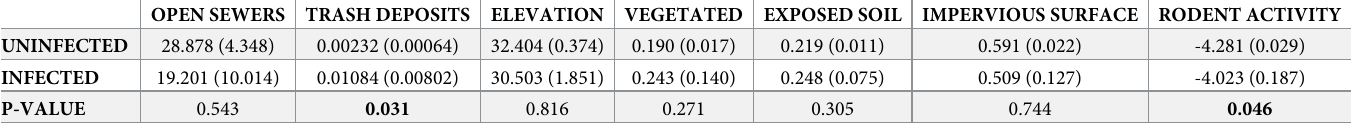
The mean (standard error) exposure to each feature during 24 hours. Exposure values were assigned to a grid of points with 2.5 meter spacing that covered the entire study area. Each GPS point’s exposure value was calculated using a Gaussian kernel centered on the GPS point and summarizing the exposure values of nearby gridpoints. Exposure measures are best interpreted as a relative